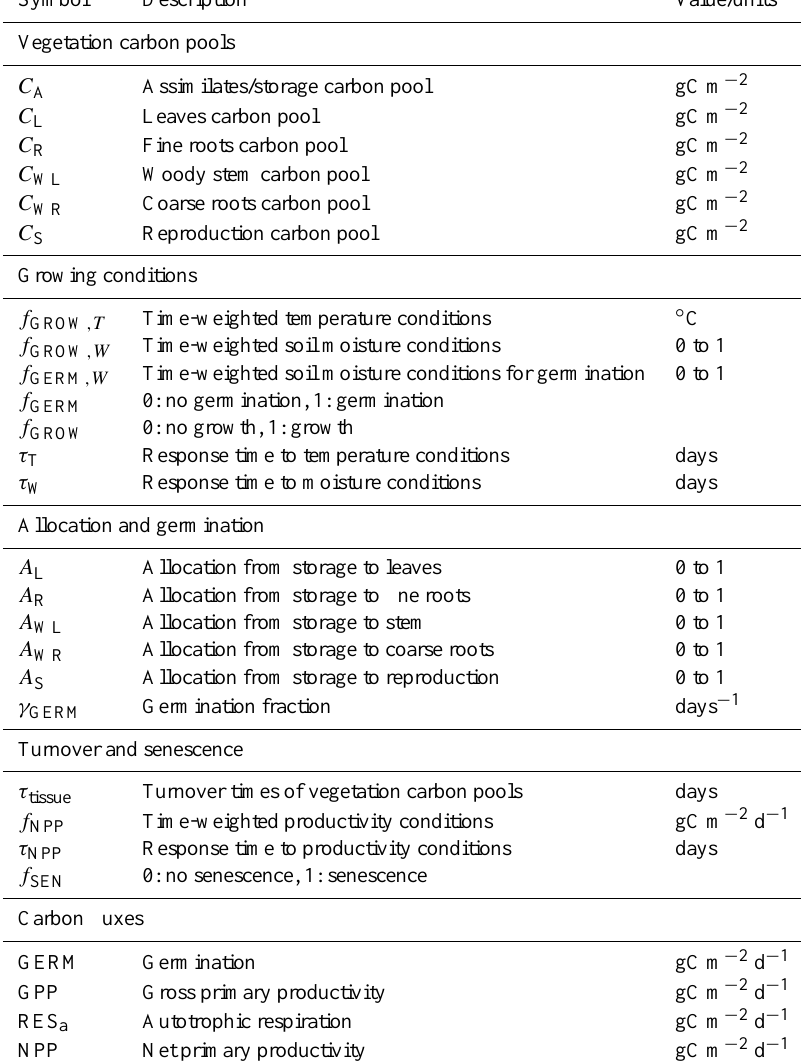
Table C1. State variables and parameters of the plant growth